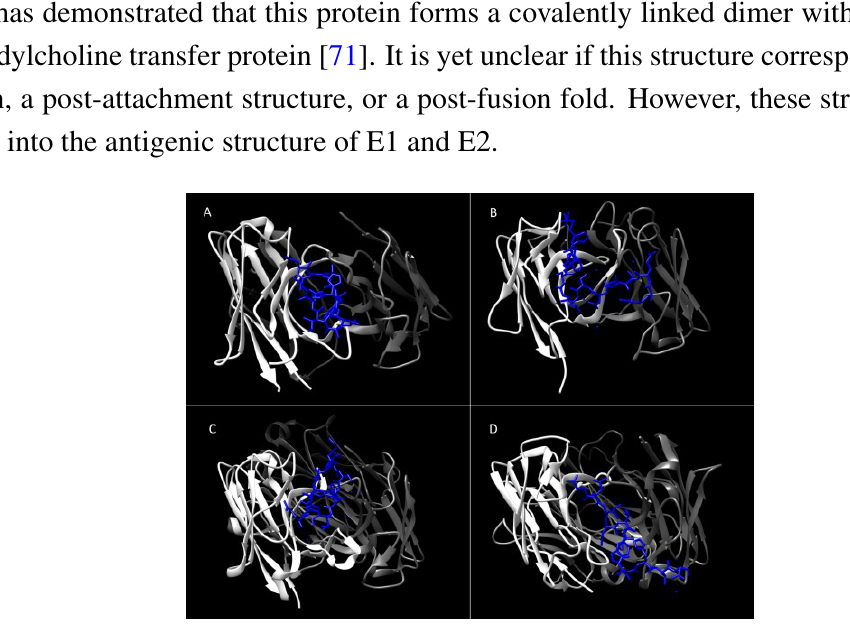
Figure 2. Structural flexibility in the N-terminus of E2. Peptides representing the amino acids 412–424 of the HCV polyprotein (blue) were crystalized in complex with monoclonal antibodies (in each case the heavy chain is highlighted in white and light chain in grey). ( A ) AP33 [63,65]; ( B ) HC33.1 [66]; ( C ) HCV1 [65]; ( D ) 3/11 [62]. The contrasting structures of this region when in complex with different antibodies, ranging from a β-turn structure (( A ) and ( C )) to an extended coil (( B ) and ( D )). This suggests that the conserved N-terminus